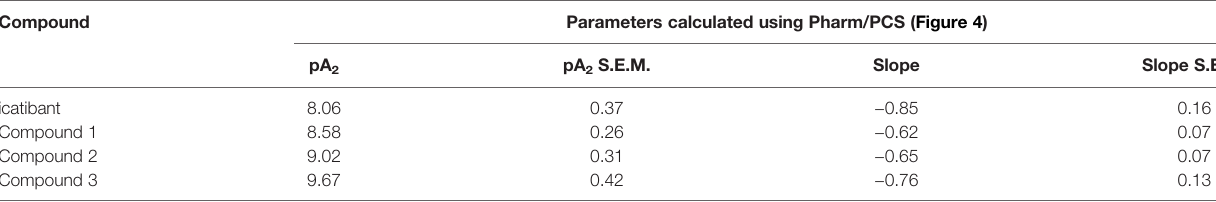
TABLE 4 | pA 2 value estimates for compounds tested as B 2 receptor antagonists using the umbilical vein contractility assay. Compound